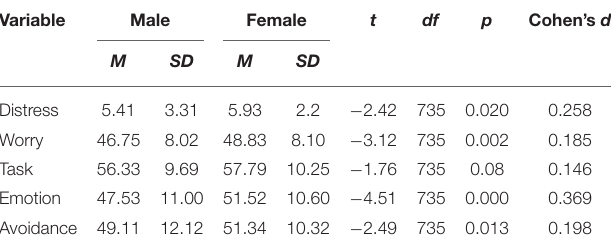
TABLE 5 | Gender differences in distress, worry, and